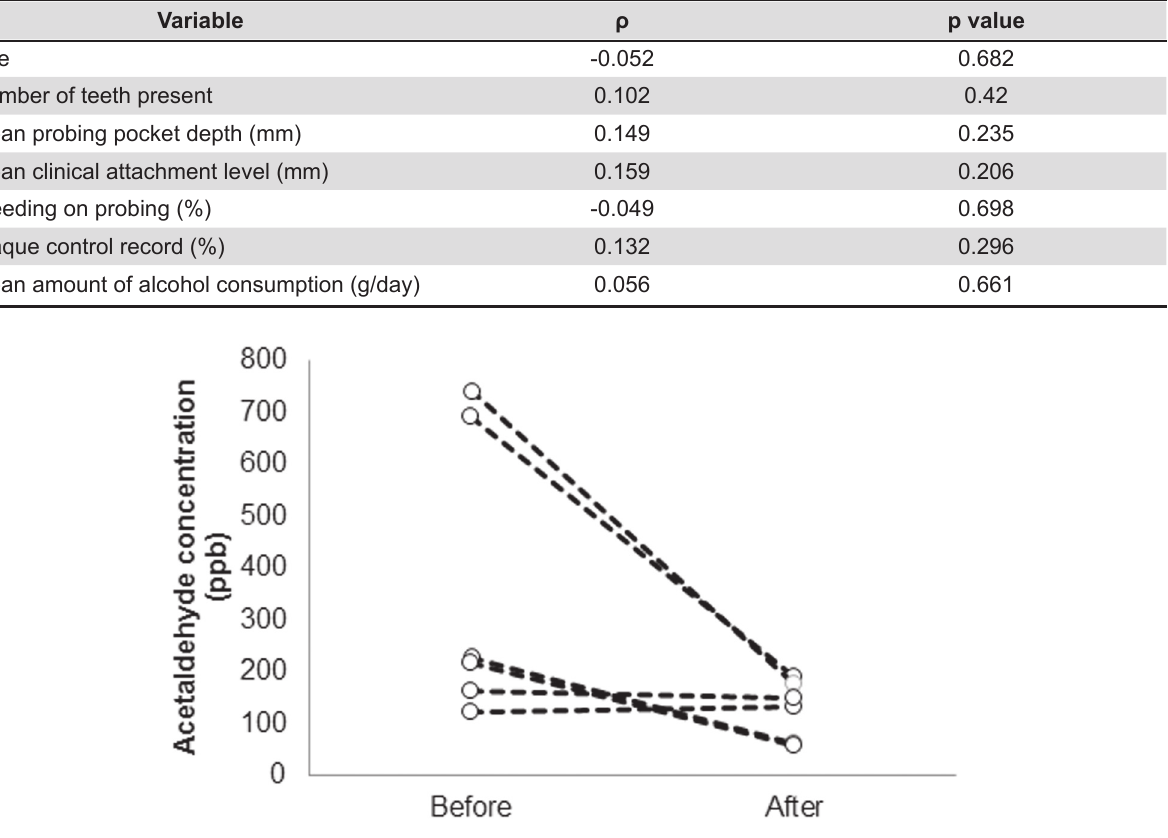
Figure 2- Acetaldehyde concentration in mouth air before and after tongue coating removal. Acetaldehyde concentration